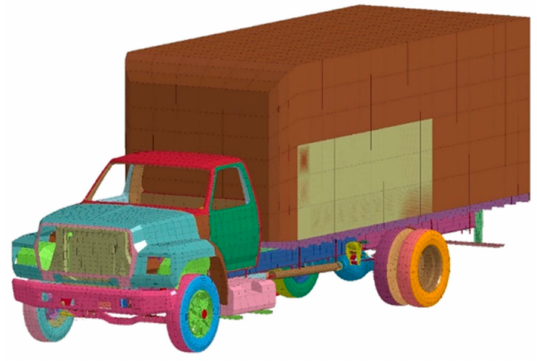
Figure 29. F800 single unit Finite element model